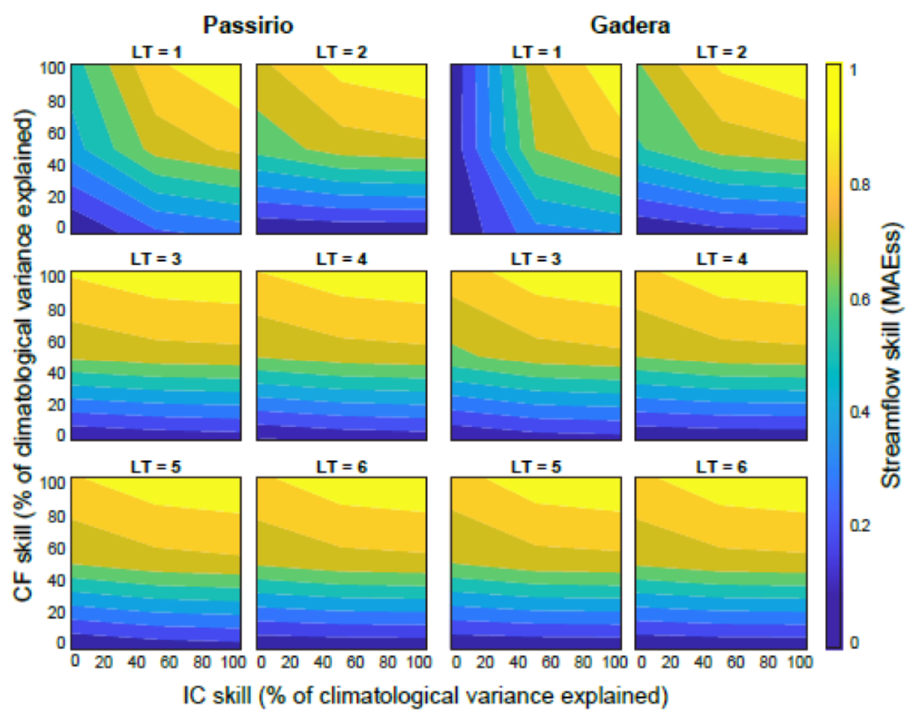
Figure 9. As in Figure 6 but for forecast initialization on 1 September.